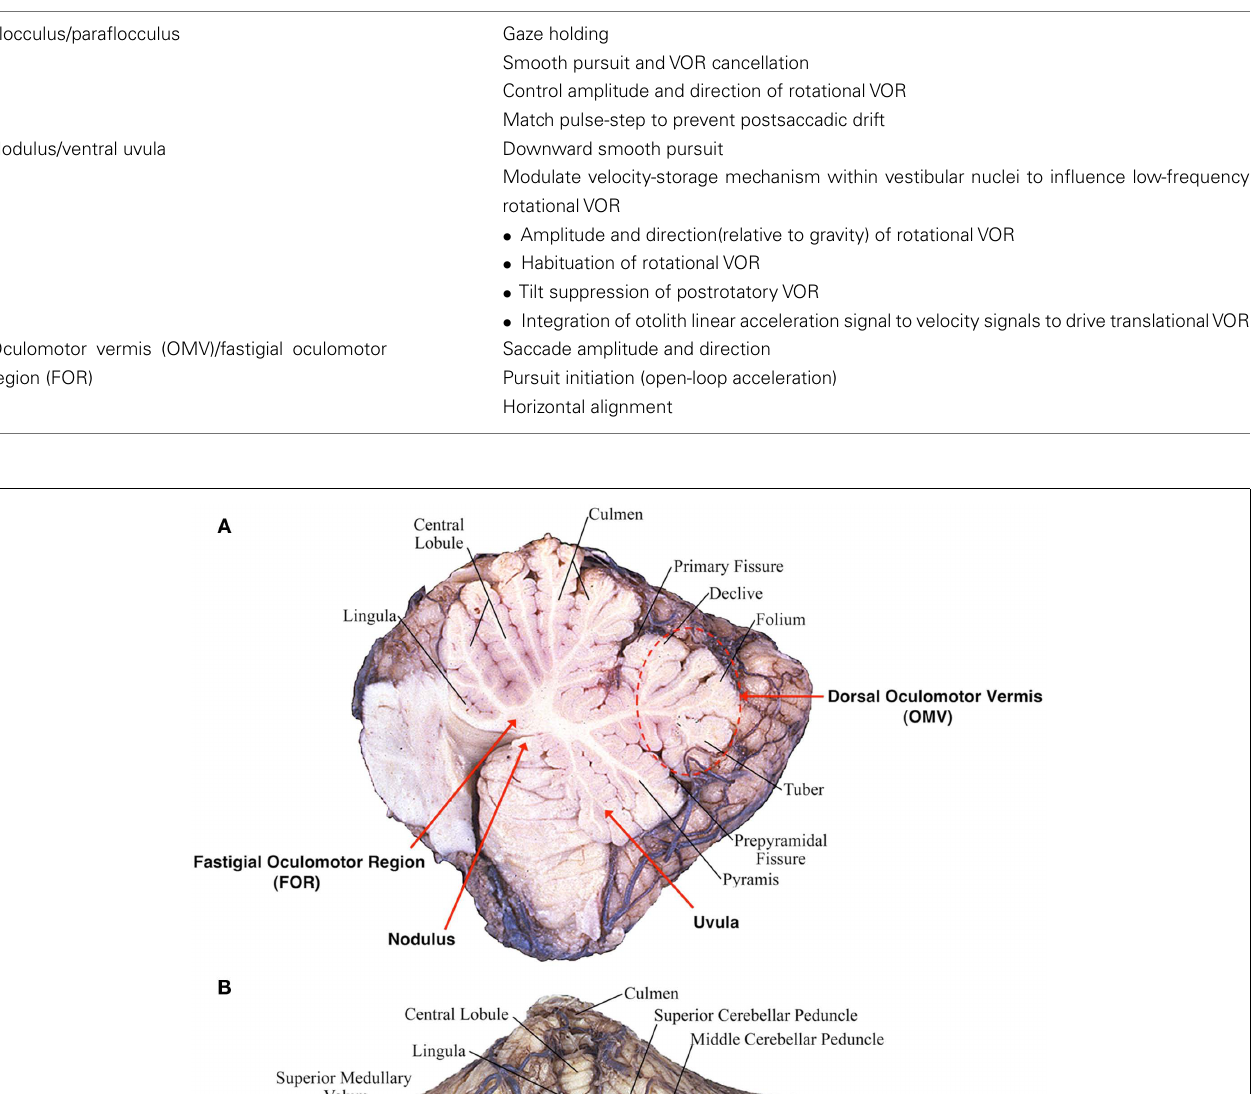
the flocculus/paraflocculus discharge in relation to the stimulus (e.g., head motion or visual target motion), to the position of the eye in the orbit during fixation, and to the movements of